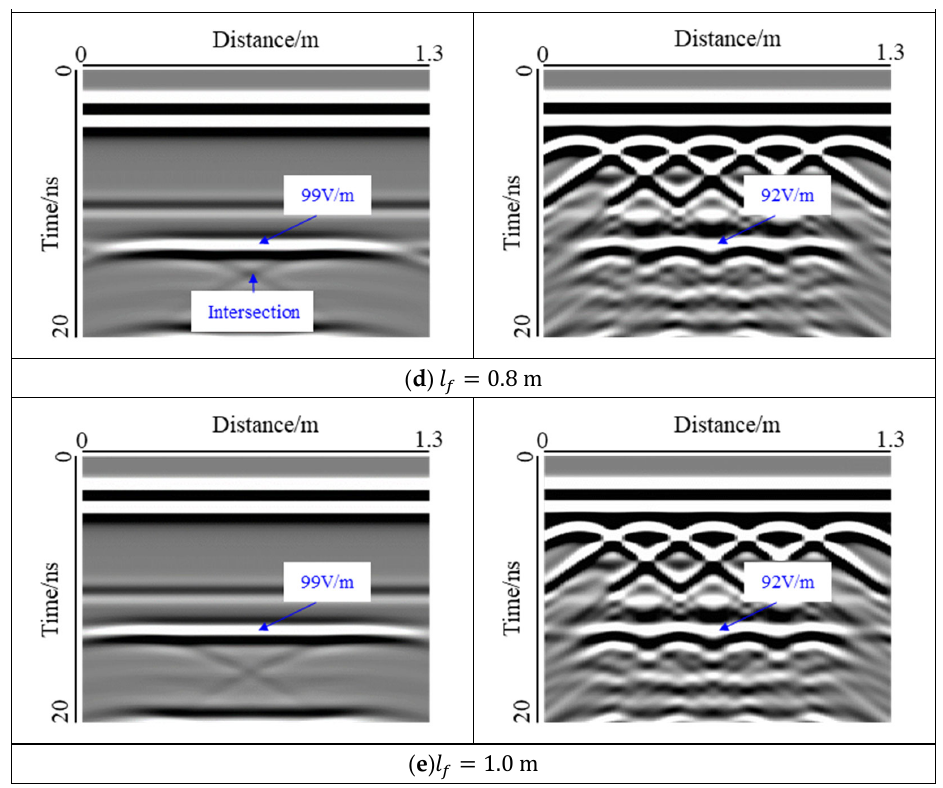
Figure 10. Influence of the water ‐ filled void width at interface Ⅱ . Because the void was far away from the steel bar, the interference of the diffracted wave was smaller, and the void response could be observed more clearly.